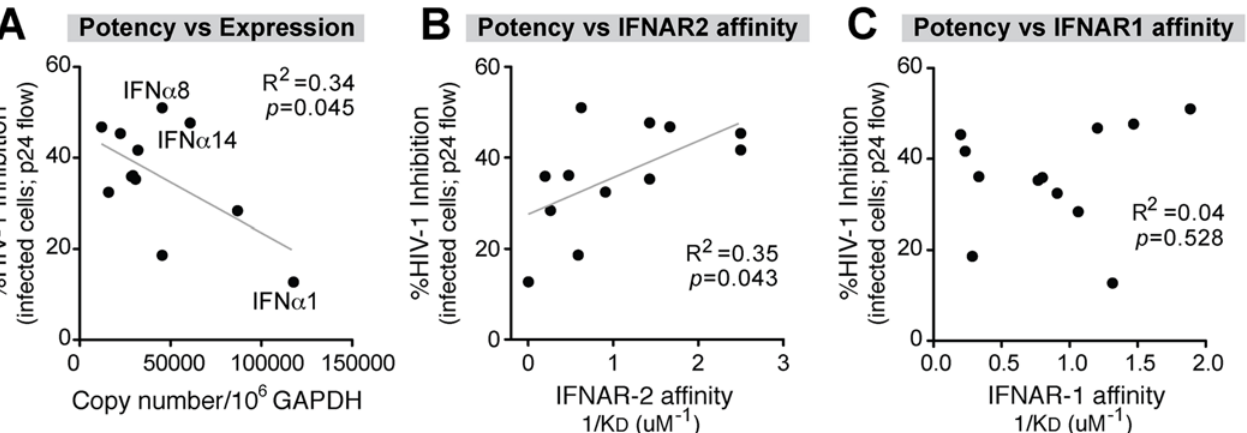
Fig 3. Correlation between IFN α antiviral potency and various parameters. Percent cellular HIV-1 inhibition values relative to no IFN α treatment control were obtained from Fig 2C. (A) Correlation between IFN α potency and absolute IFNA subtype copy numbers, based on multiplying % IFNA distribution in Fig 1D and total IFNA copies in Fig 1B. IFN α subtype potencies were also correlated with non-log-transformed binding affinity (1/K D or K A ) to (B) IFNAR-2 and (C) IFNAR-1 based on published data [22]. For all panels, Pearson correlation analysis was performed, with R 2 values and p -values shown. Best-fit linear regression curves are shown in the correlation was significant ( p <